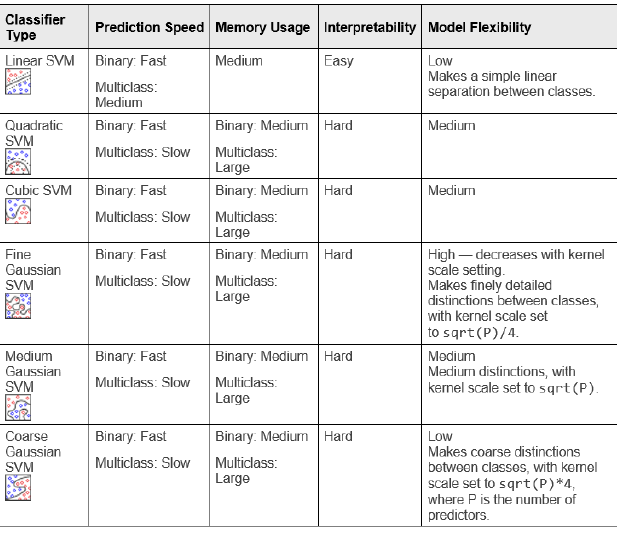
Table 1. Comparison of Kernel functions